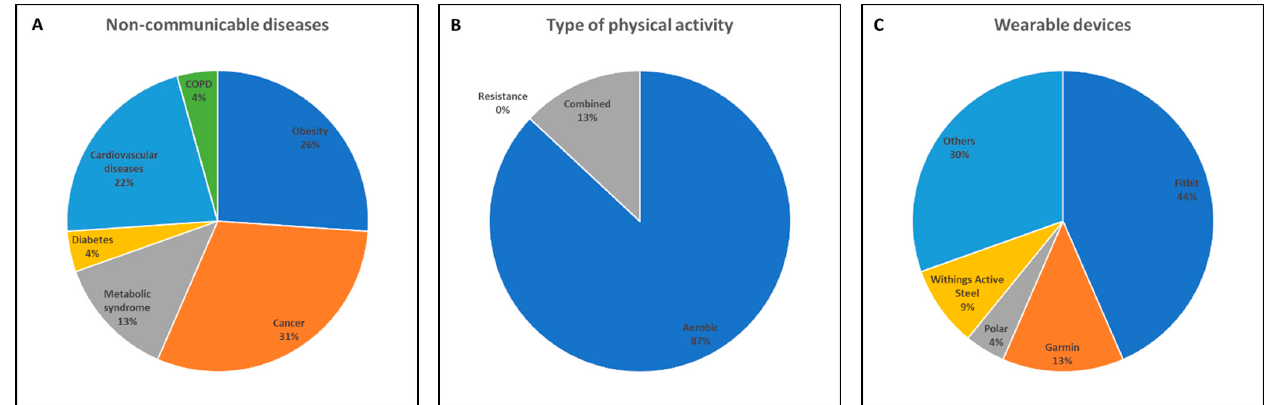
Figure 1. Pie charts of non-communicable diseases ( A ), type of physical activity ( B ), and wearable devices ( C ) used in the RCTs from 2016 to 2022.